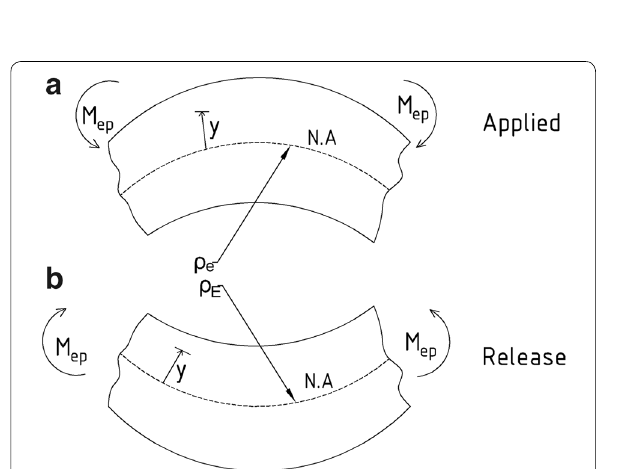
Fig. 15 Curvatures for applied moment